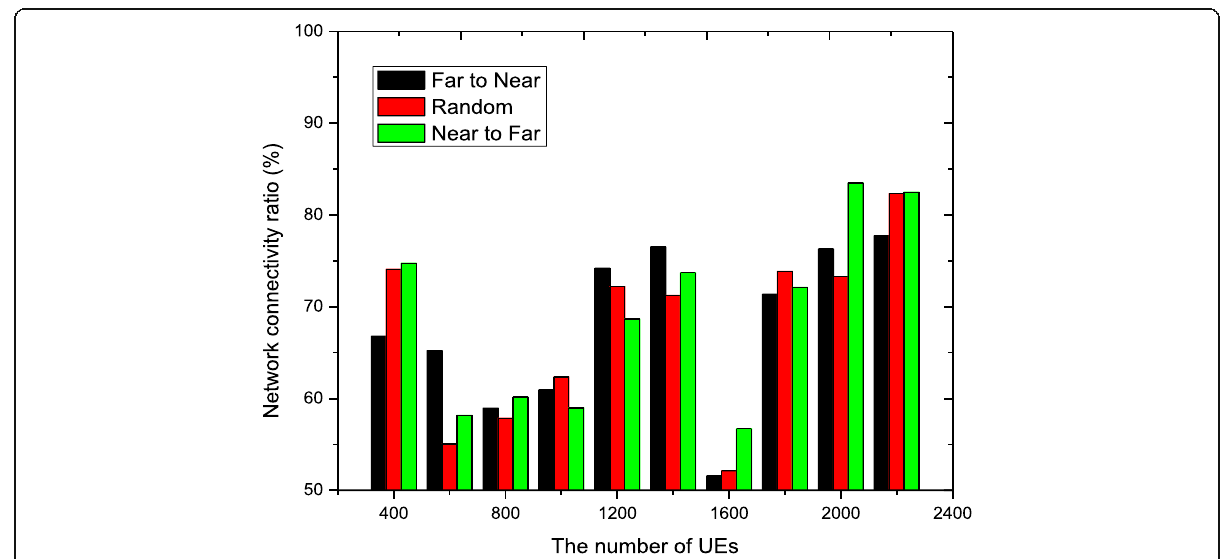
Fig. 18 Network connectivity ratio for the DTO-MROD scheme under the different verification orders of relay preselection